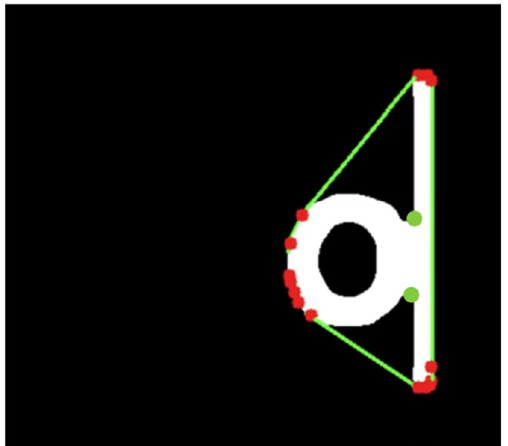
Fig. 6 Convexity defects for sticking characters Separation. Green Dot for separation point, Red Dot for non-separation